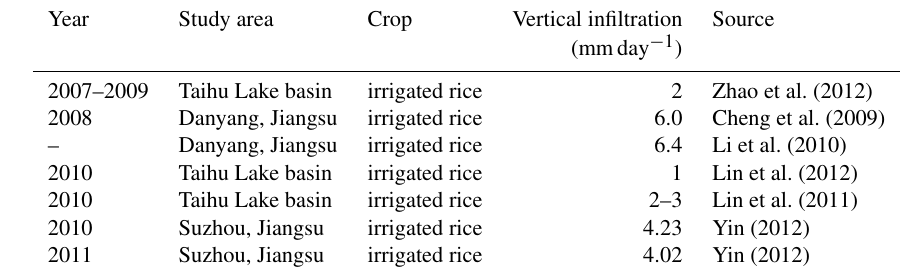
Table 2. Vertical infiltration of different paddy fields in Taihu Lake basin.